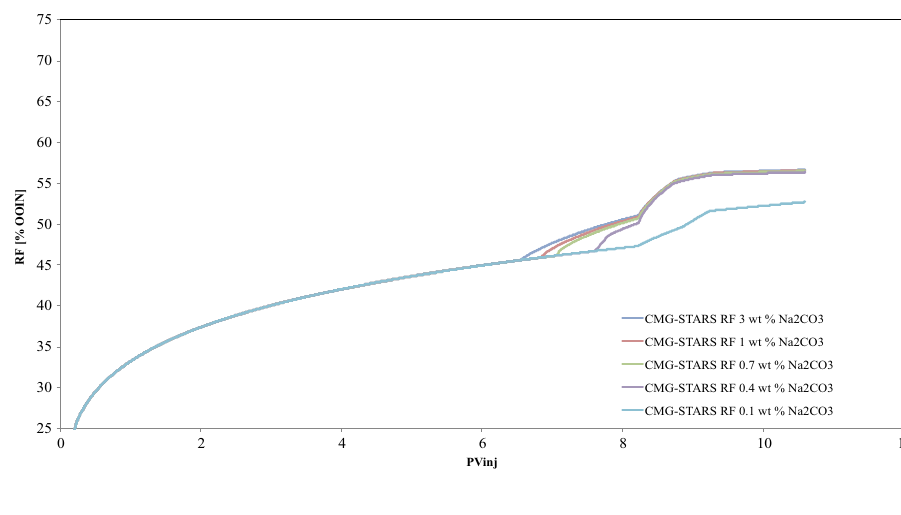
Fig. 15 The effect of Na concentration on the RF